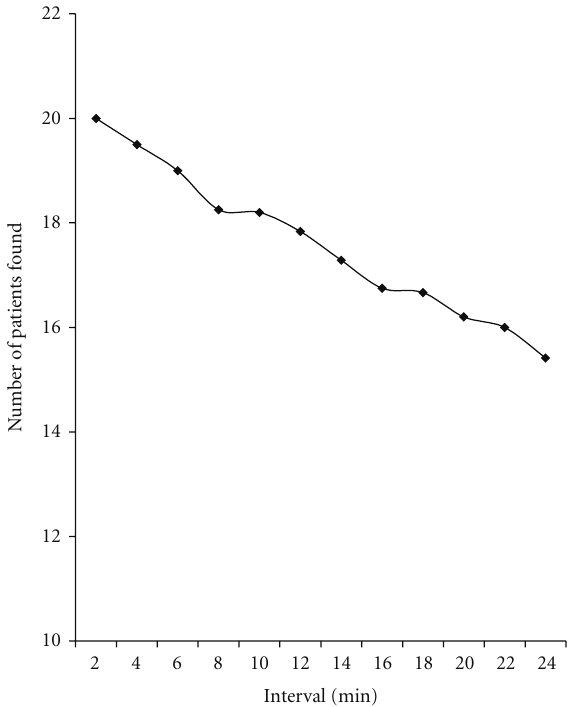
Figure 2: Time interval of blood pressure beat-to-beat measure- ments related to the detection of postprandial hypotension in 22 geriatric patients.